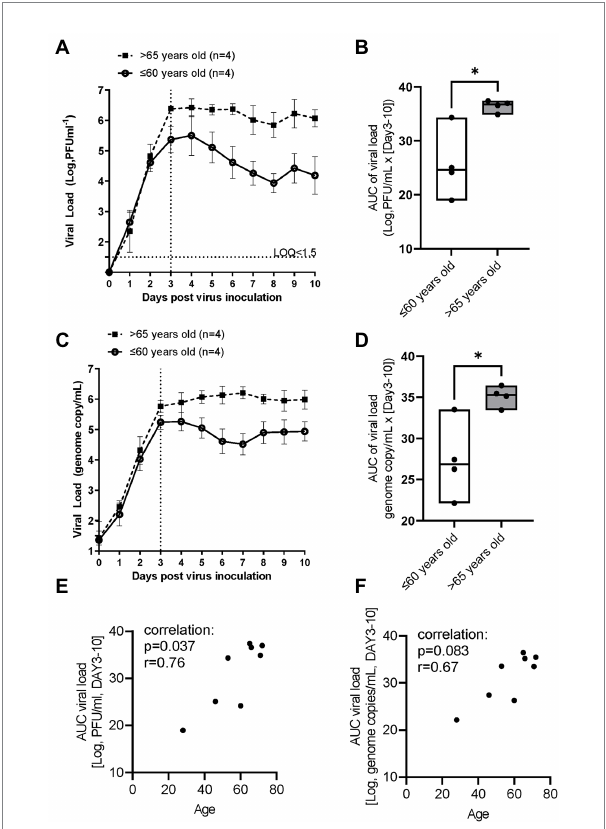
FIGURE1 The comparison of RSV A2 viral load in apical washes collected from ALI-bronchial epithelium post RSV A2 inoculation in younger ( ≤ 60 years old) and elderly (>65 years old) groups. (A) Time-profile of viral load determined by plaque assay, mean ± SEM. (B) AUC (Day 3–10) of viral load determined by plaque assay, min-max with median. (C) Time-profile of viral load determined by qRT-PCR. (D) AUC (Day 3–10) of viral load determined by qRT-PCR. A correlation between age and viral load by plaque assay (E) and qRT- PCR (F) . * p < 0.05, the LOQ is 1.5 log, PFU/mL for a plaque assay, and virus load lower than LOQ was shown as